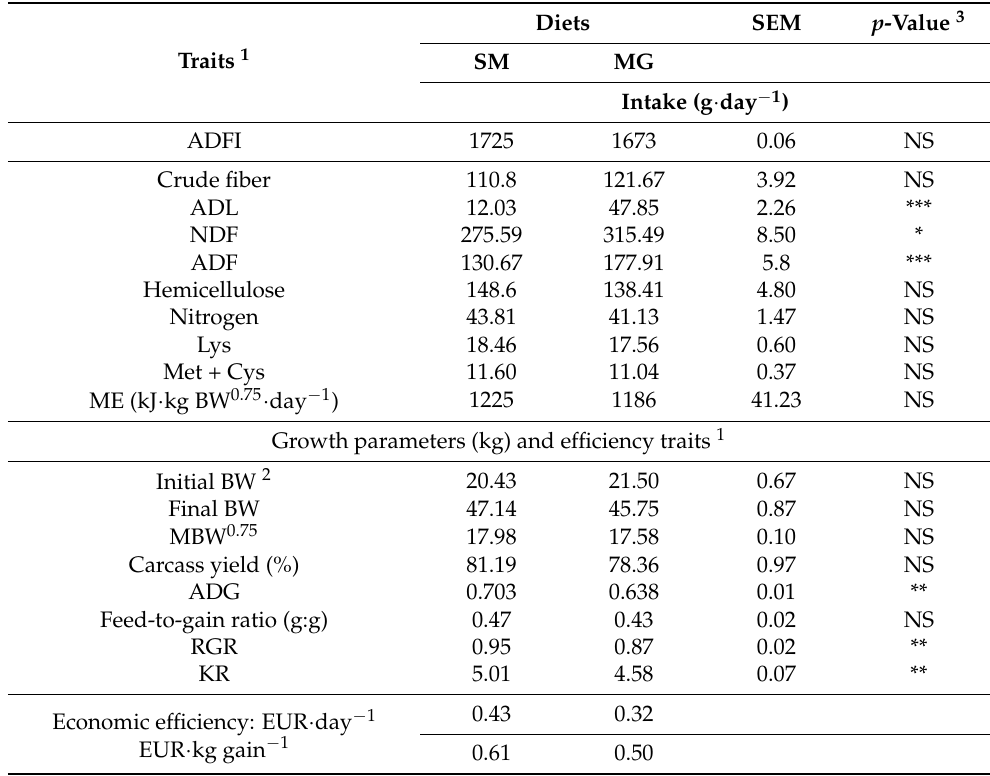
Table 3. Descriptive statistics of growth parameters and efficiency traits of Topigs hybrid pigs fed